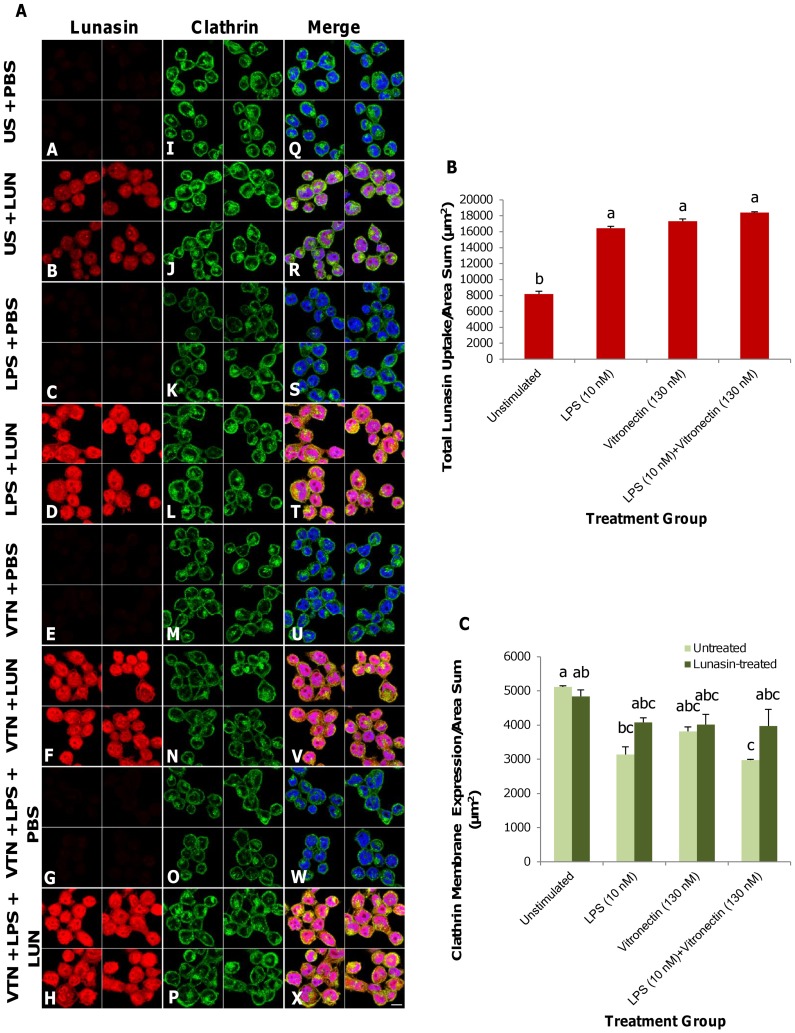
Clathrin remained constitutively expressed in stimulated macrophages treated with lunasin.Two-dimensional median optical planes demonstrating immunocytochemical localization of lunasin (red), clathrin (green) and nuclei (blue) (
Figure 3A
). Unstimulated macrophages or macrophages have been induced with LPS (10 nM), vitronectin (130 nM) or both molecules in combination for 24 h, and treated with lunasin (1 µM) for 1 h. Compared to the PBS control (A–B), lunasin uptake increased upon stimulation with LPS (C–D), vitronectin (E–F), or both molecules in combination (G–H). Induction by LPS or both molecules in combination reduced basal expression levels of clathrin at the membrane, but clathrin expression remained unaffected following lunasin treatment in all groups (I–P). Merge image (with nuclei) showing the increased lunasin uptake and the effect of clathrin at the plasma membrane surface (Q–X), and their respective expression levels (
Figure 3B, 3C
). Four independent fields of view from three independent replicates of cells were merged together per treatment group. In Figure 3B and 3C, data represent the average of triplicates or quadruplicates ± SE. Means with different letters are significantly different from each other (n = 3, p<0.05). US  =  unstimulated, PBS  =  phosphate buffer saline, LPS  =  lipopolysaccharide (10 nM), VTN  =  vitronectin (130 nM), LUN  =  lunasin (1 µM). Bar  = 10 µm.